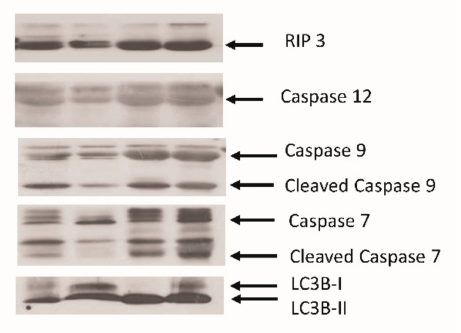
Figure 4. Protein expression in BAL exosomes. Various proteins associated with autophagy, necroptosis, and apoptosis were expressed in nonspecific patterns in BAL exosomes of ARDS patients.